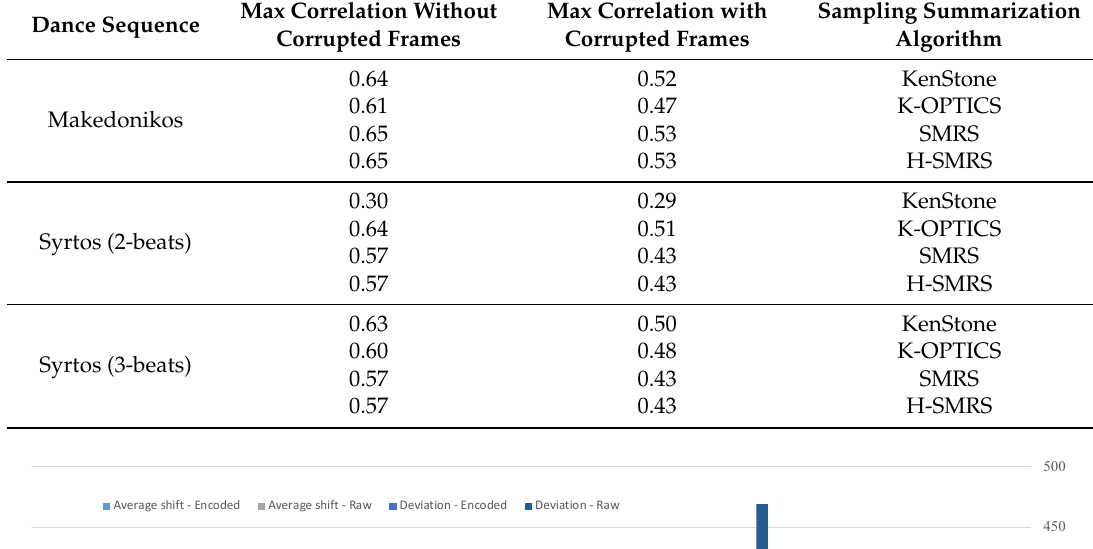
) for different sampling algorithms and i